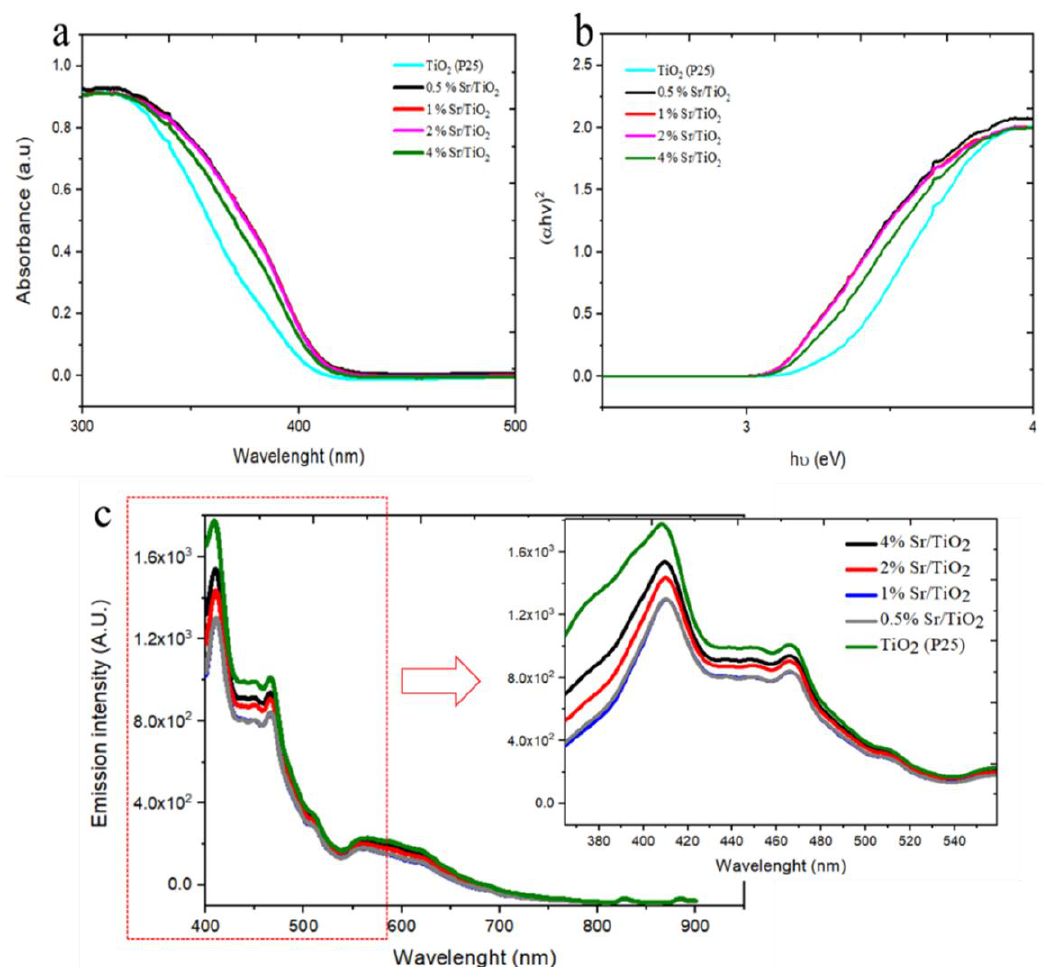
Figure 1. ( a ) UV-vis absorption spectra; ( b ) Tauc plots from UV-vis absorption spectra of TiO 2 and Sr-doped TiO 2; and ( c ) PL spectra of TiO 2 and Sr-doped TiO 2 photocatalysts (excitation wavelength = 320 nm). Table 1. Energy bandgaps and anatase (101) 2θ of XRD peaks of TiO 2 and Sr-doped TiO 2 photocata- lysts.